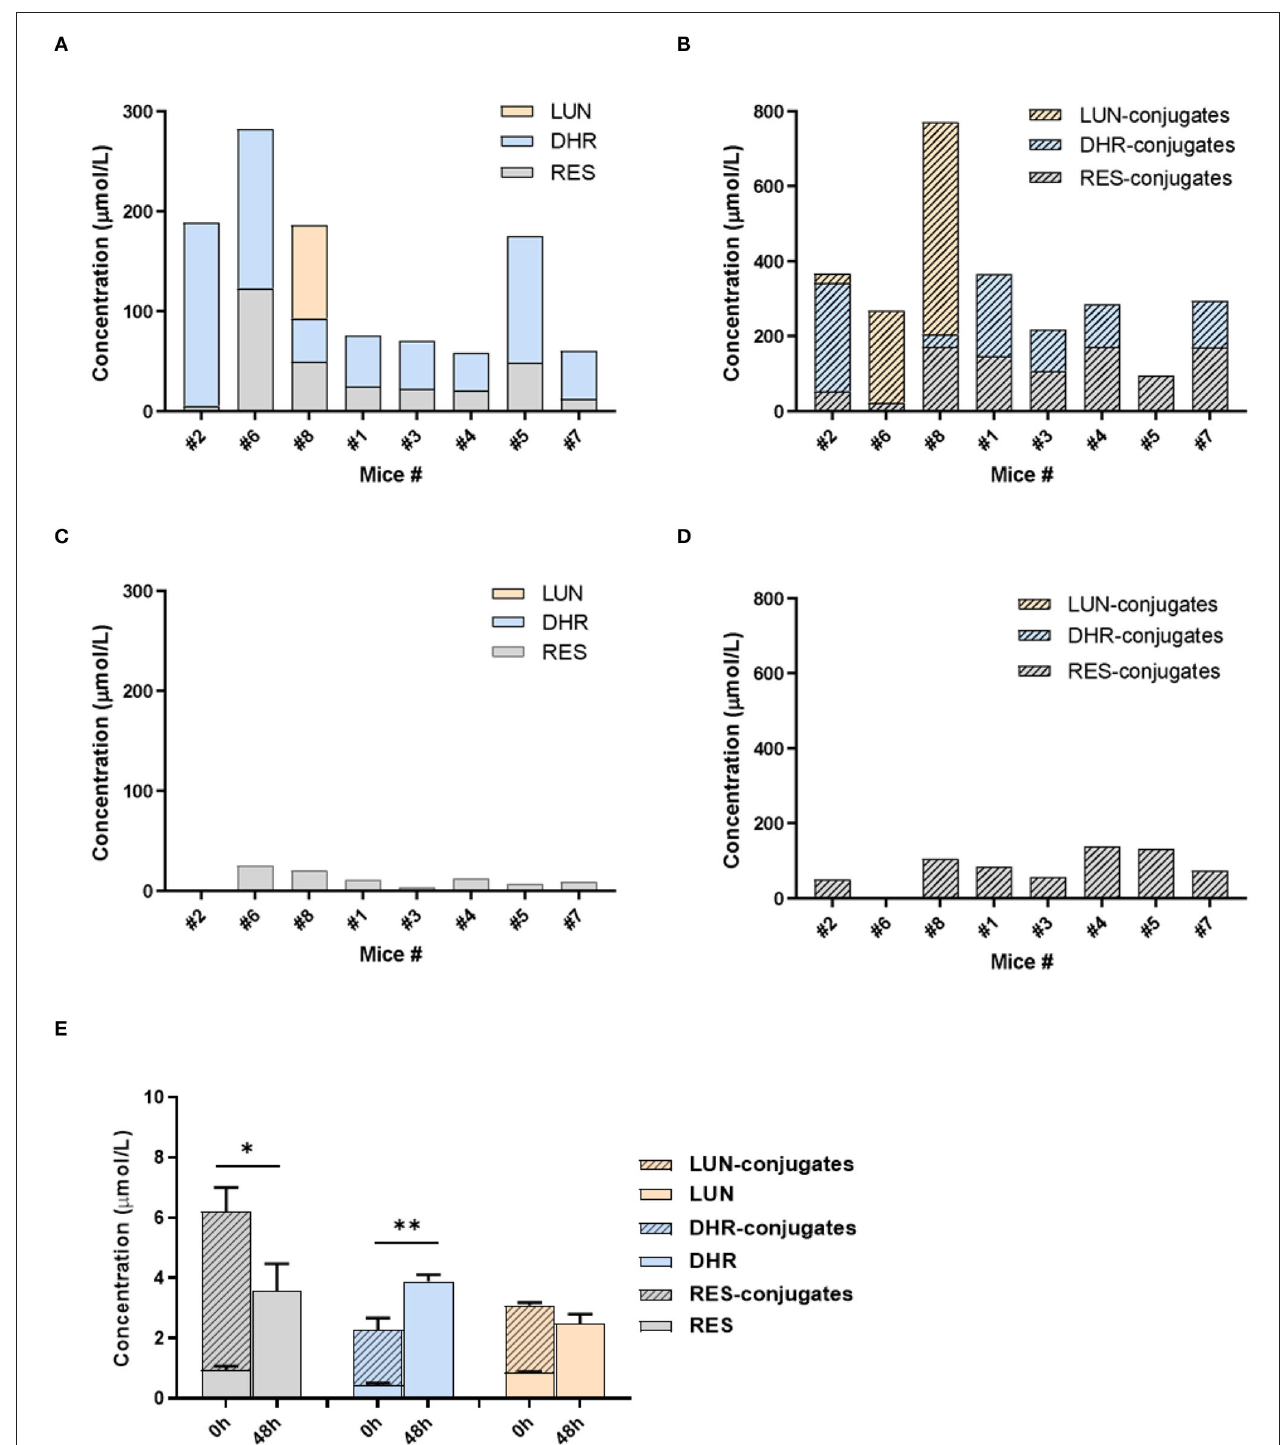
FIGURE 4 | Gut microbiota-mediated RES biotransformation. The concentrations of RES, DHR, LUN, and their conjugates in the urine before antibiotic treatment (A,B) . The concentrations of RES, DHR, LUN, and their conjugates in the urine after antibiotic treatment (C,D) . The concentration of RES, DHR, LUN, and their conjugates in SI digesta before and after anaerobic fermentation with mouse fecal bacteria (E) . Three independent experiments were performed (E) . Significant differences are indicated: * P < 0.05, ** P < 0.01 (E) . Mice were numbered as number (#) 1, #2, #3 …to #8 in our experiment, which was described in the text of “The Role of Gut Microbiota in the Biotransformation of